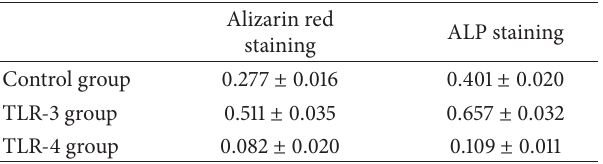
Alizarin red ALP staining staining